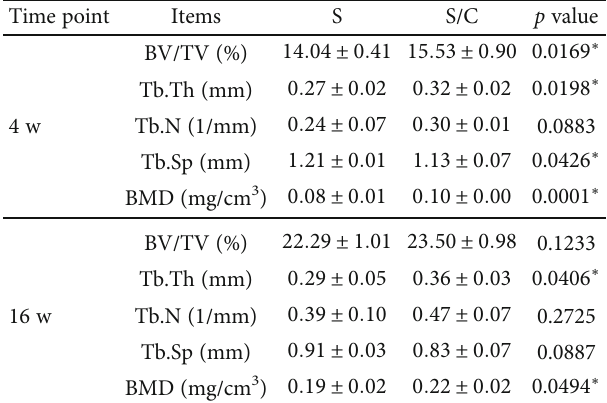
Figure 9: Representative micro-CT images. Few mineralized tissues were detected at the graft – bone interface at 4 weeks postoperatively (a, S group; b, S/C group). At 16 weeks postoperatively, distinct signals appeared indicating new mineralized tissue regeneration at the graft – bone interface of each group (c, S group; d, S/C group). The mineralized tissue signal and average bone tunnel area may indicate bone integration at the graft – bone interface. Table 1: Micro-CT evaluations ( mean ± SD ). BV/TV, Tb.Th, and BMD increased signi fi cantly more in the S/C group than in the S group at 4 weeks after reconstruction surgery. Signi fi cant increases in Tb.Th and BMD were observed in the S/C group relative to the S group. ∗ indicates a notable distinction between the two comparison